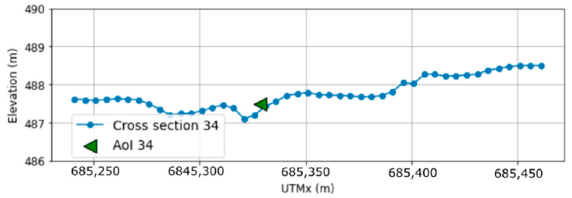
Figure 19. Cross-section at the location of the FN (section 34).